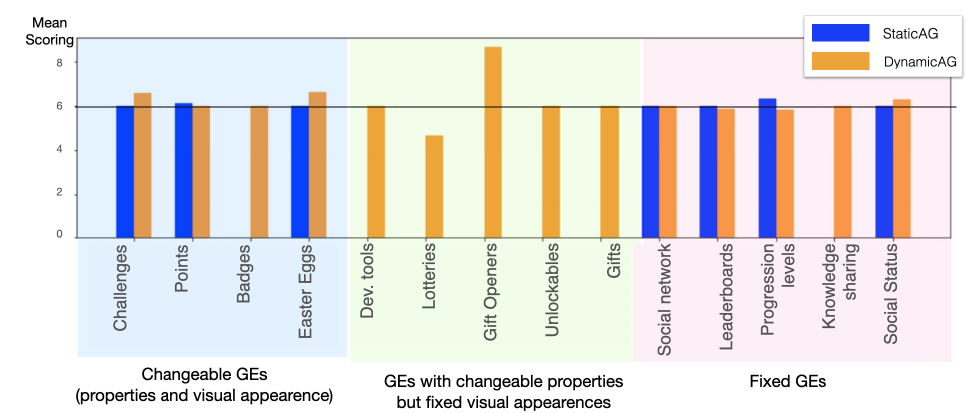
Figure 10. Evaluations , i.e., mean scoring of GEs grouped by GE type. The left side includes Change- able GEs (in both properties and appearances). In the middle, GEs that only change their properties according to the learning progress. On the right side, GEs with fixed appearances and